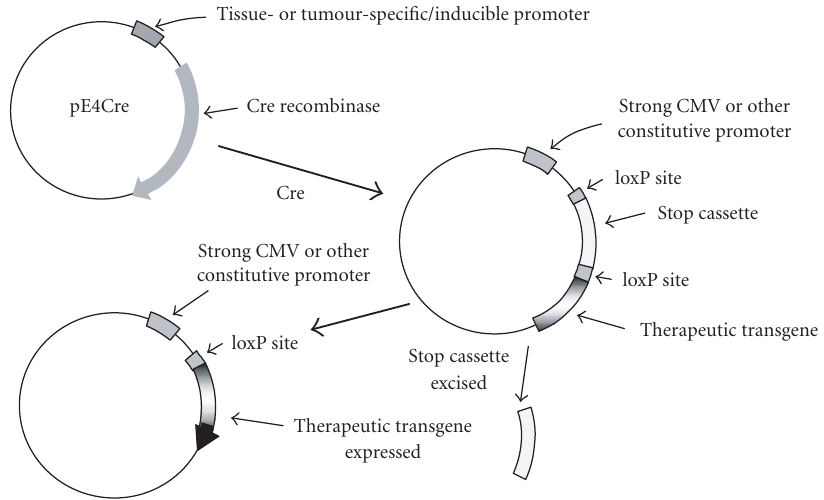
Figure 3. The Cre recombinase/loxP system for enhancing weak tissue or tumour-specific promoters. Cre, induced by the specific promoter excises the transcriptional stop cassette via the loxP sites. This brings the therapeutic transgene under the control of a strong constitutive promoter (eg,